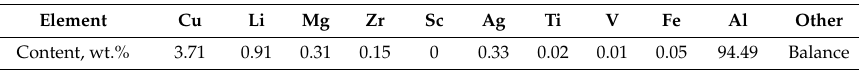
Table 1. Chemical composition of the input aluminum alloy.